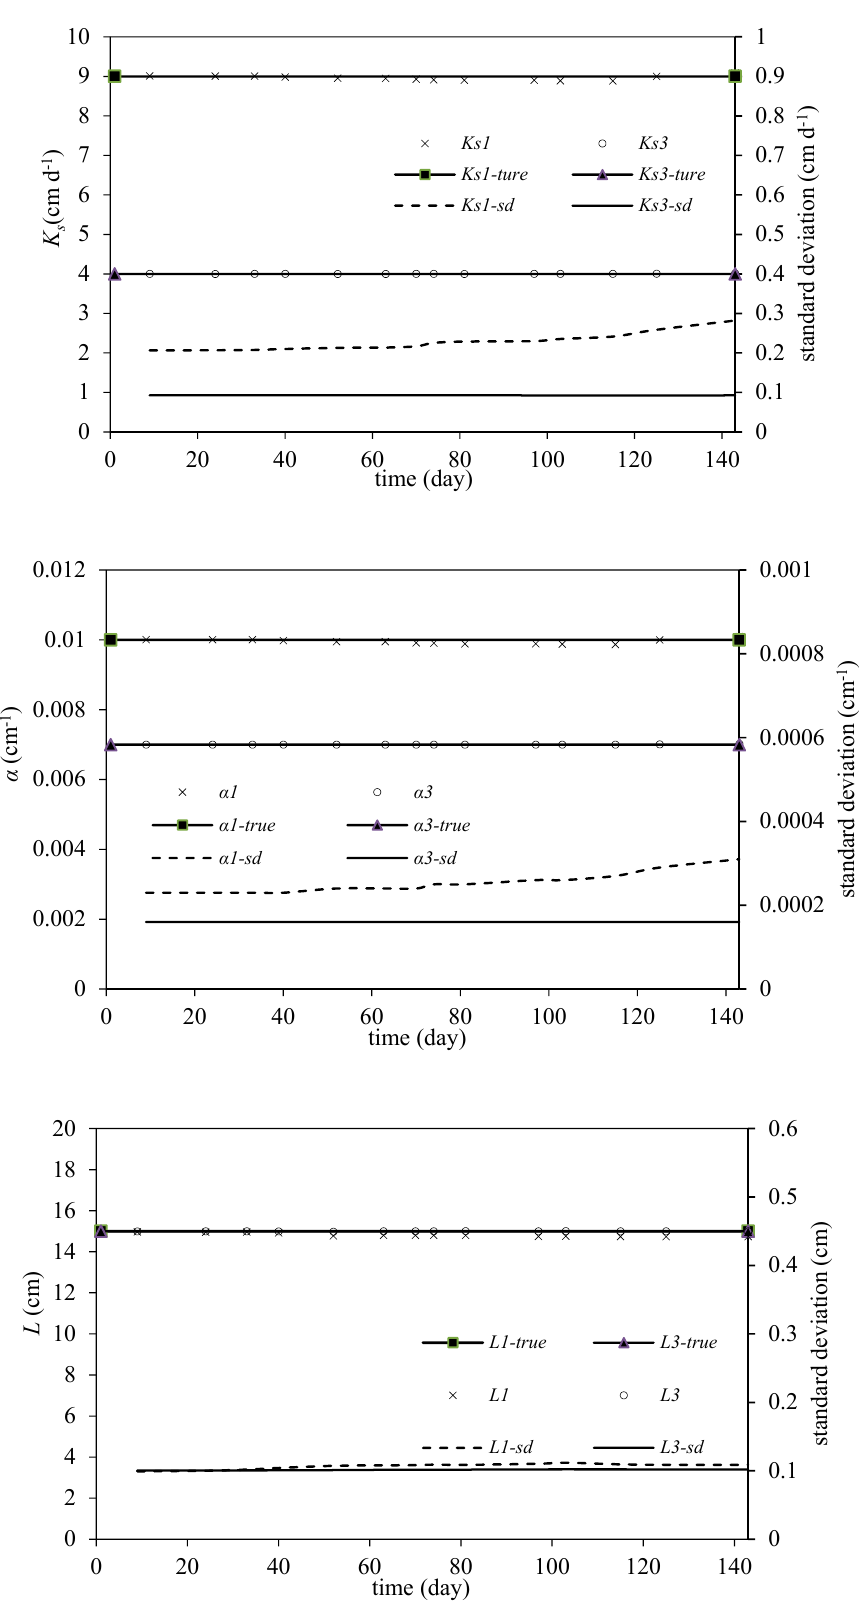
Figure 7. Evolution of the estimated hydraulic conductivity ( K s ), shape parameter ( α ), and longitudinal dispersivity ( L ) values with assimilation of the soil moisture and salinity.